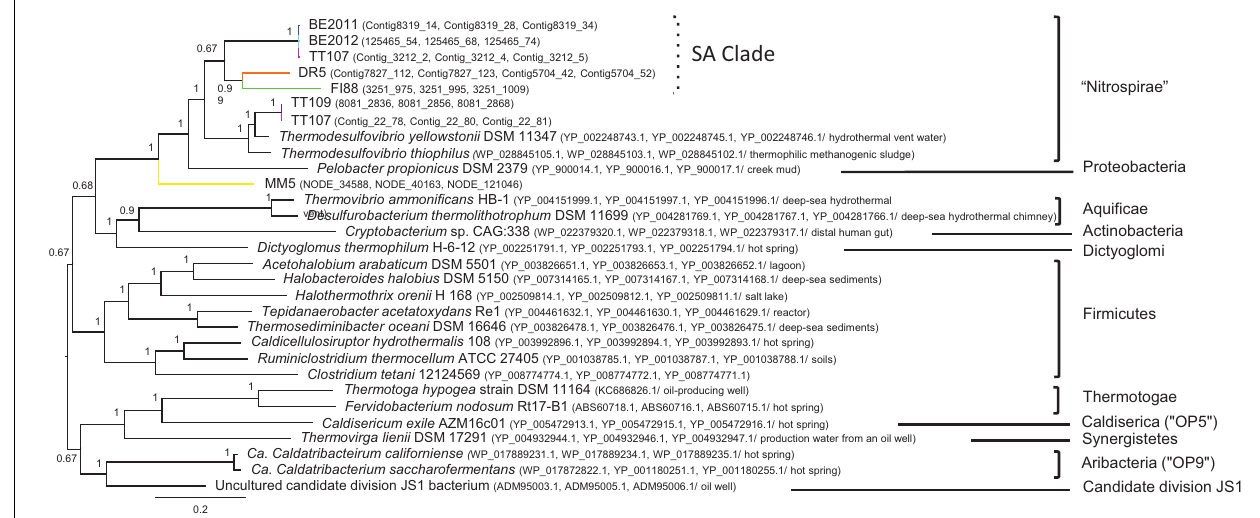
GenBank accession numbers and, if available, the source of isolates. Phyla are given to the right of the tree. Nodes are supported by posterior probability and scale bar represents the amino acid substitution rate per site.